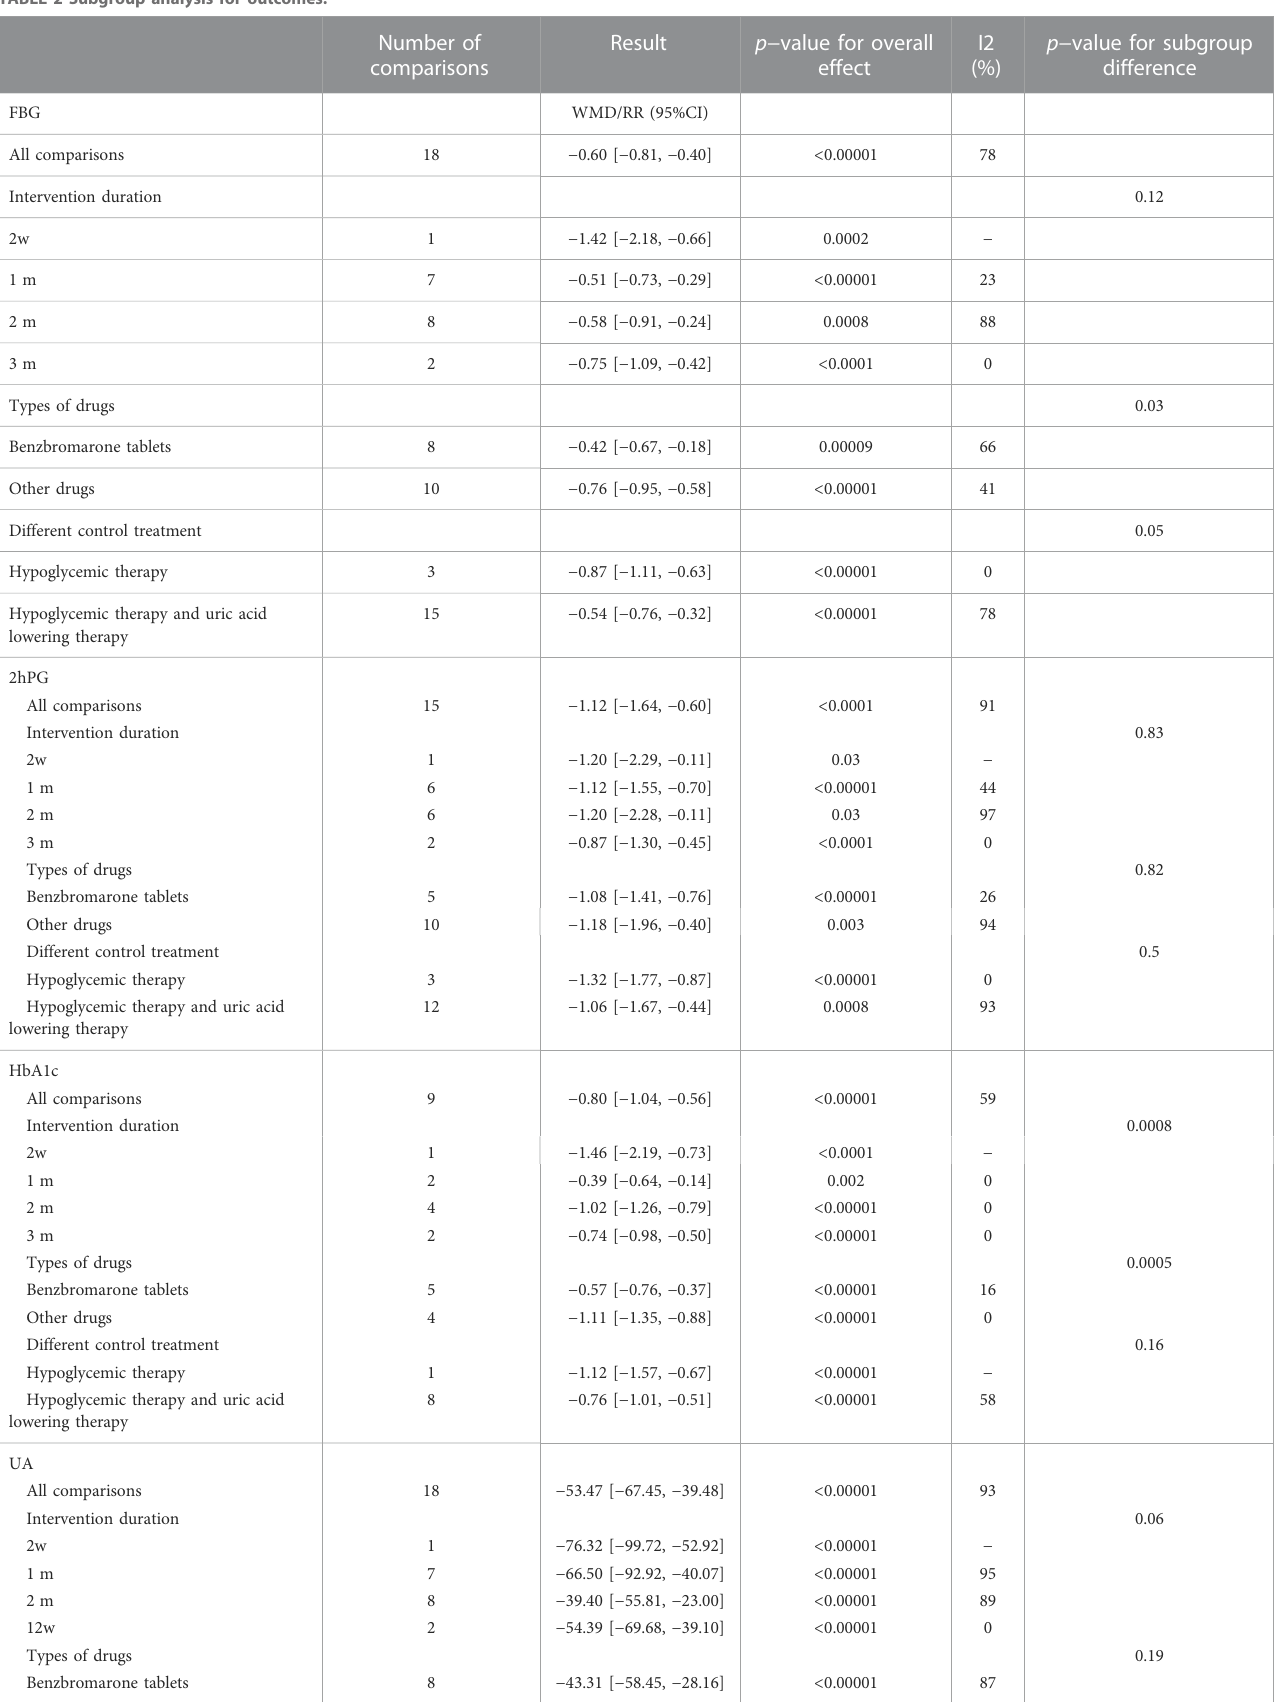
TABLE 2 Subgroup analysis for